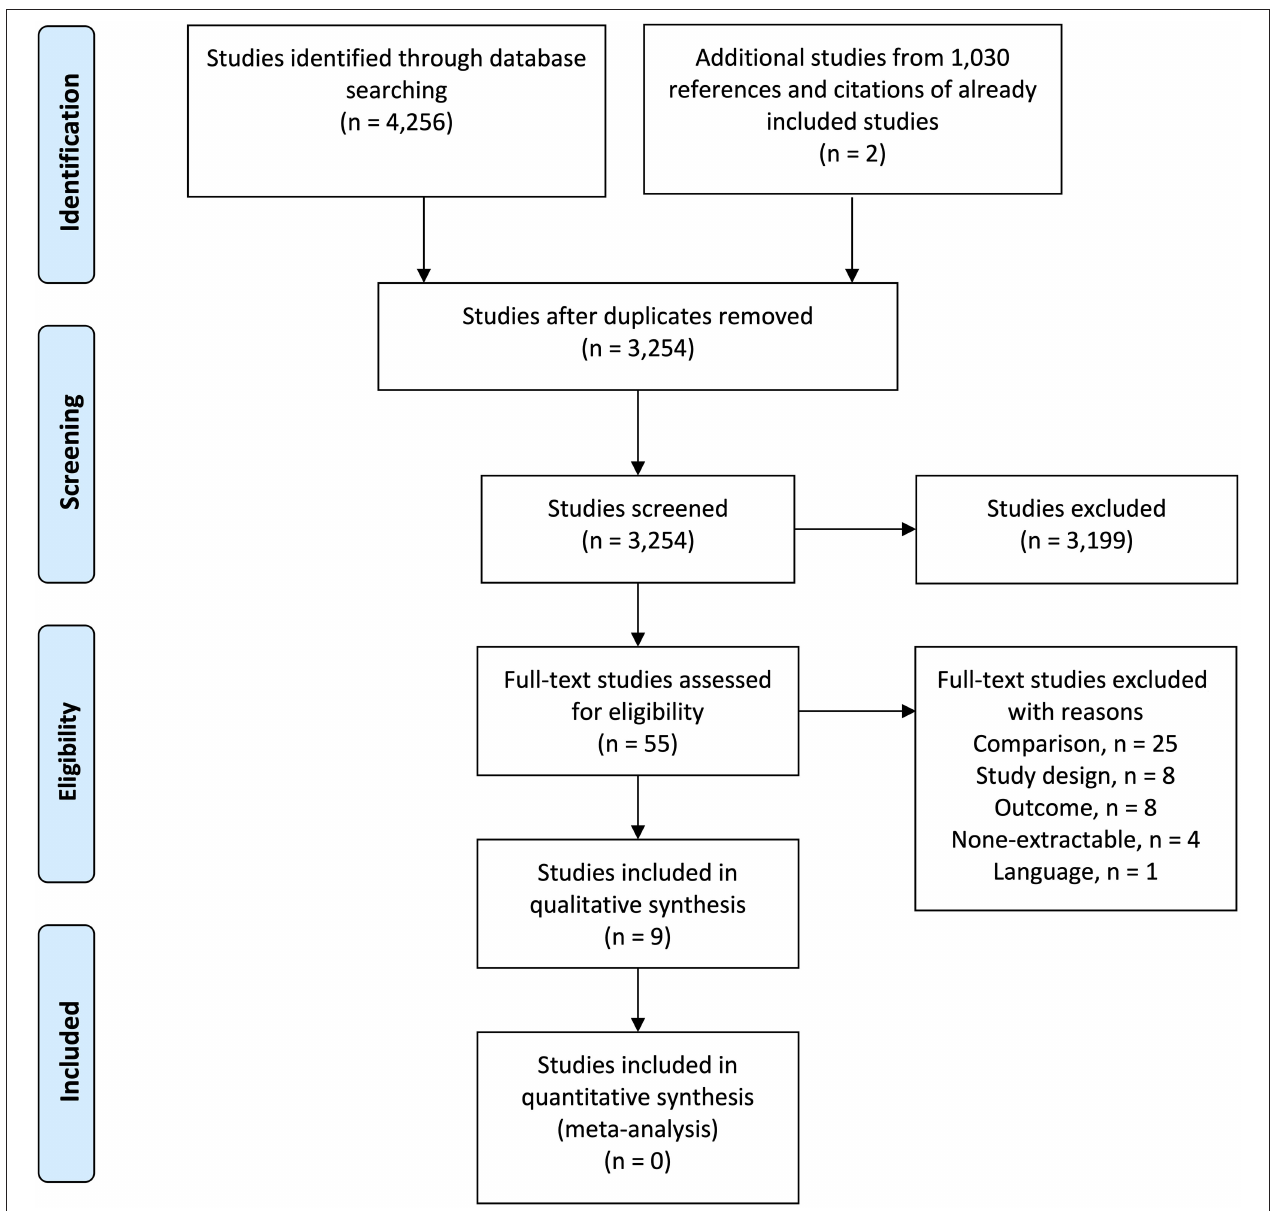
FIGURE 1 | PRISMA flow diagram of the study selection